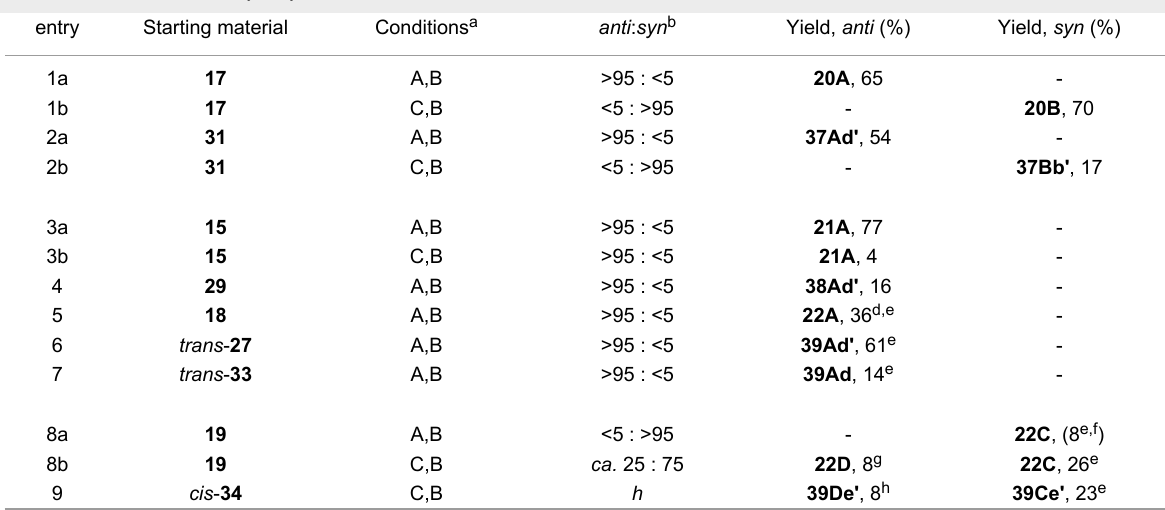
Table 1: Diastereoselective dihydroxylation reactions